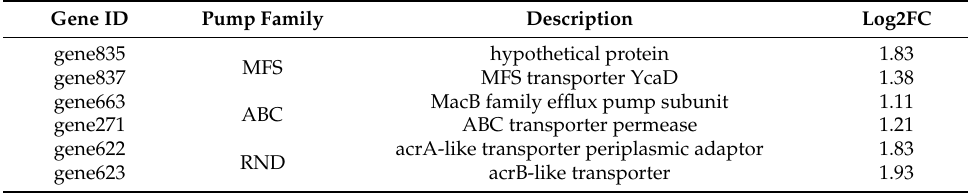
Table 4. Overexpression efflux pump of transcriptome.